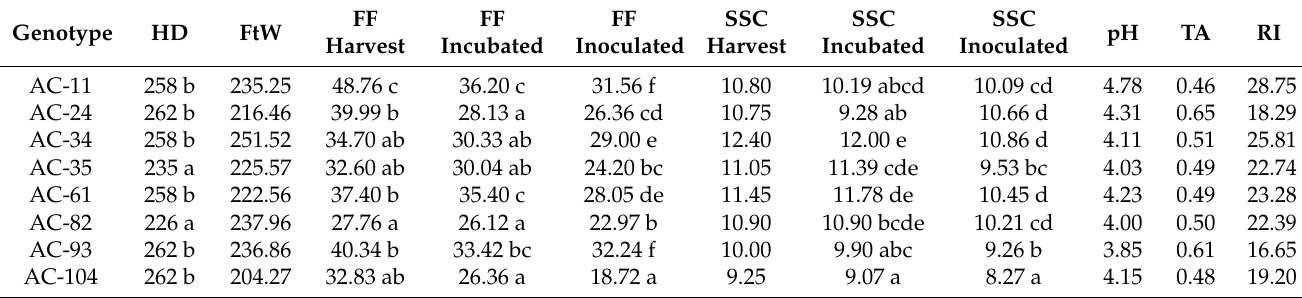
Table 2. Physicochemical basic quality traits in eight selected genotypes derived from the ‘An- dross’ × ‘Calante’ cross evaluated during the two years of study (2014–2015). Data are mean values of N = 2–36 replications (see also Table S2). At harvest, FF was measured in 10 fruits; SSC, pH and TA parameters were evaluated in a mixed pool of 10 fruits. In storage, FF and SSC were measured in 5 fruits that were non-inoculated and in 20 fruits that were